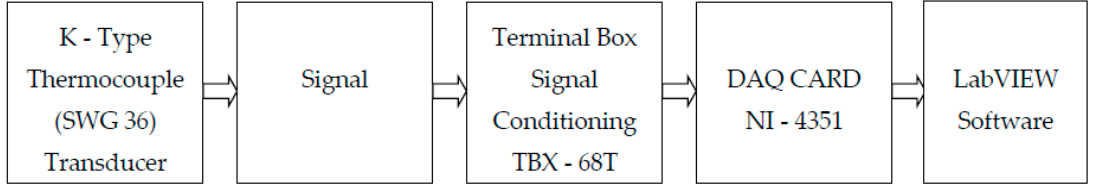
Figure 3. Flow diagram for data transfer in a DAQ system: Temperature.